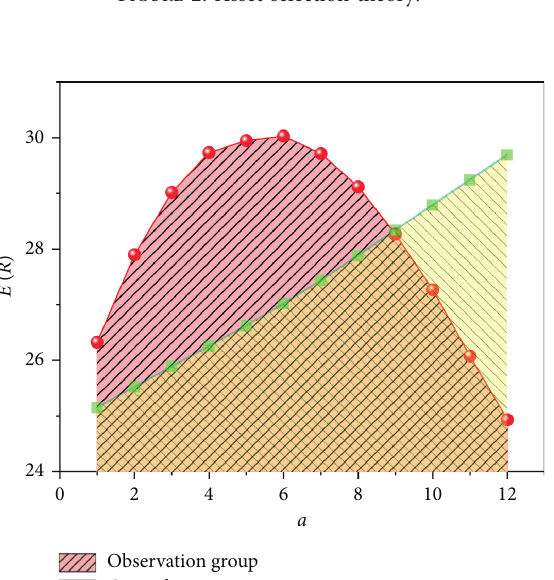
Figure 2: Asset selection